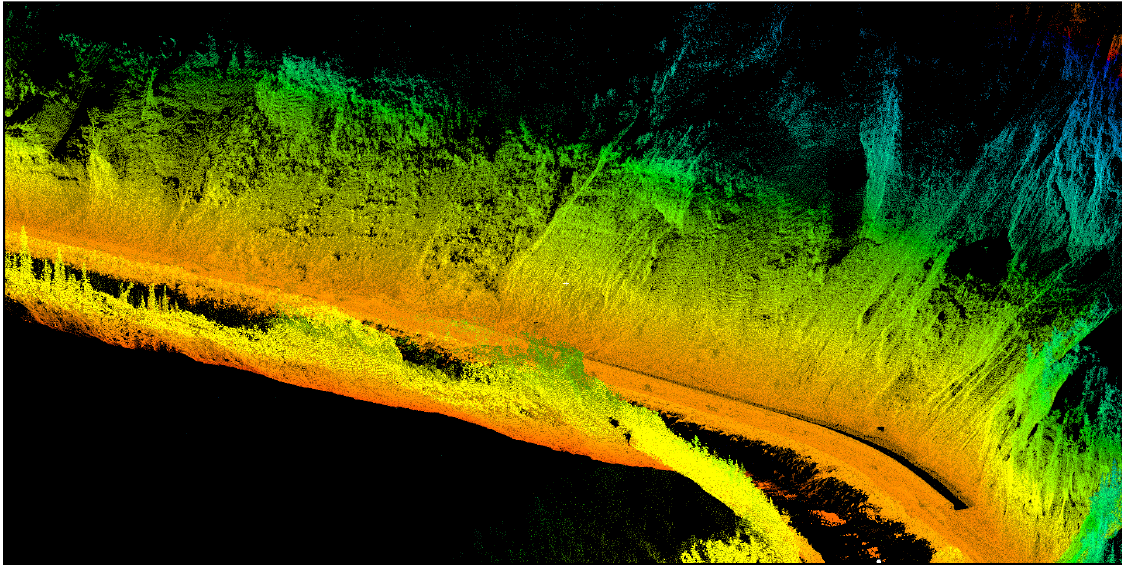
Figure 14. Point cloud for MLS data obtained for slope stability assessment on the Parks Highway near Denali National Park,